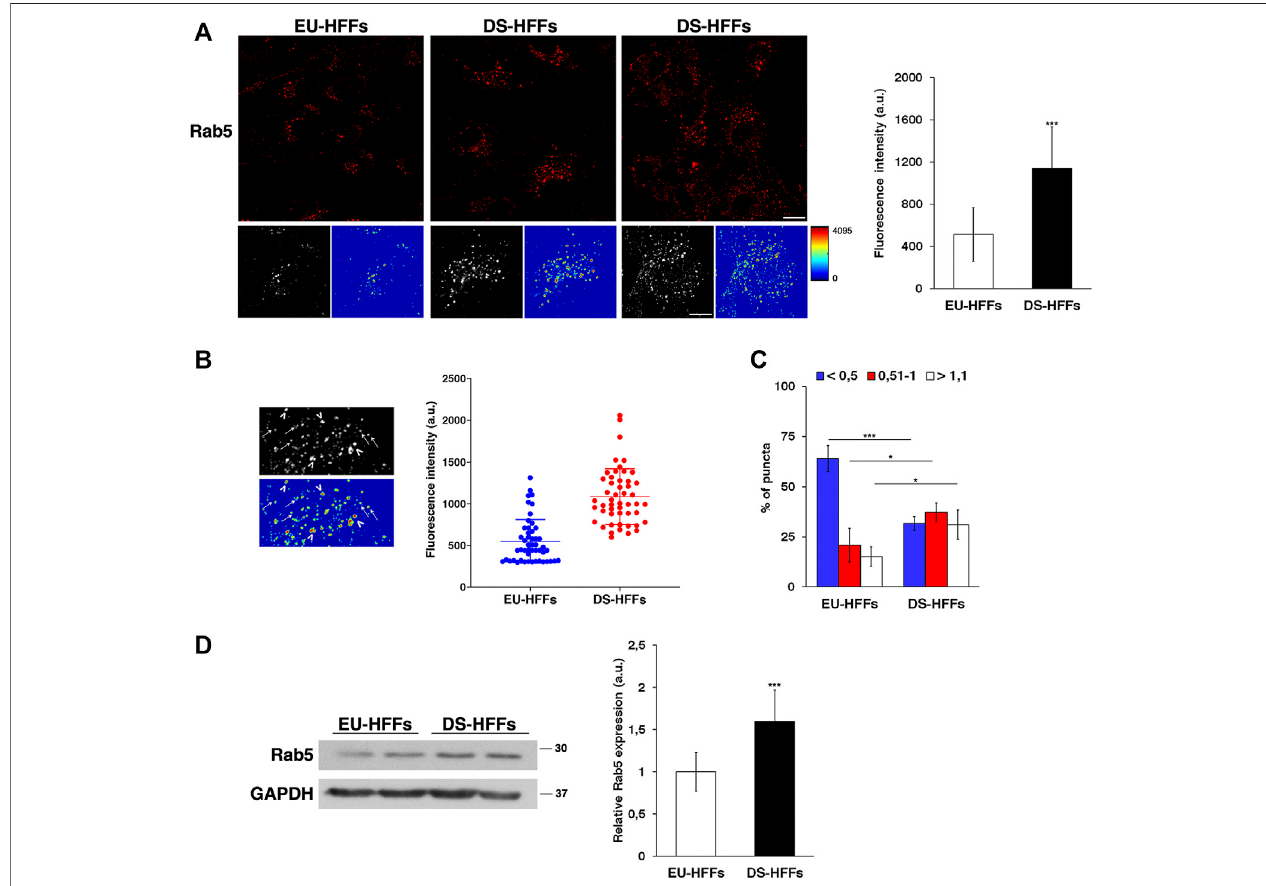
FIGURE 3 | The dynamics of early endosomes is perturbed in DS-HFFs. (A) EU-HFFs and DS-HFFs were stained with Rab5 antibody detected with Alexa-546- conjugatedsecondaryantibodies.Serialconfocalsectionswerecollectedfromthetoptothebottomofthecells.Foreachcondition,the3Dreconstructionandcorresponding intensity map are shown. Scale bars, 8 μ m. Mean fl uorescence intensity(arbitrary unit,a.u.) of Rab5-positive structures ishigher in DS-HFFs than in EU-HFFs. The bars show therelativemeanvalue±SDofthreeindependentexperiments. (B) Representative3DreconstructionandcorrespondingintensitymapofcellROIstakenintoanalysis(left panels).TwopopulationsofRab5endosomesaredistinguishableintermsofbrightness,withlower(arrows)andhigher(arrowheads)intensity fl uorescentsignal.Representative scatterdotplotshowingthedistributionof fl uorescenceintensityofRab5-positivestructuresinEU-HFFsandDS-HFFs(rightpanel).Eachdotrepresentsonesamplevalue,error barsrepresentmeanvalue±SD. (C) ThepercentageoflargerRab5positivestructures( > 1 μ m)areincreasedinDS-HFFswhencomparedtothatinEU-HFFs.Thebarsshow therelative meanvalue ±SDof threeindependentexperiments, n ≥ 30 cells. (D) Representativeimmunoblotting of Rab5inDS-HFFs and EU-HFFs. GAPDHwas usedas the loading control. The molecular weight of protein markers is indicated. Densitometric analysis of three different experiments, performed in three euploid and in four trisomic cultures, is shown. Error bars, mean ± SD. * p < 0.05; *** p < 0.001, Student ’ s t -test.